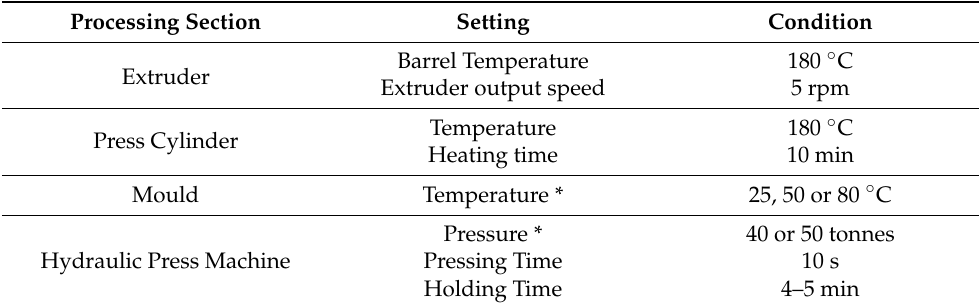
Table 4. Injection moulding process conditions for the optimisation